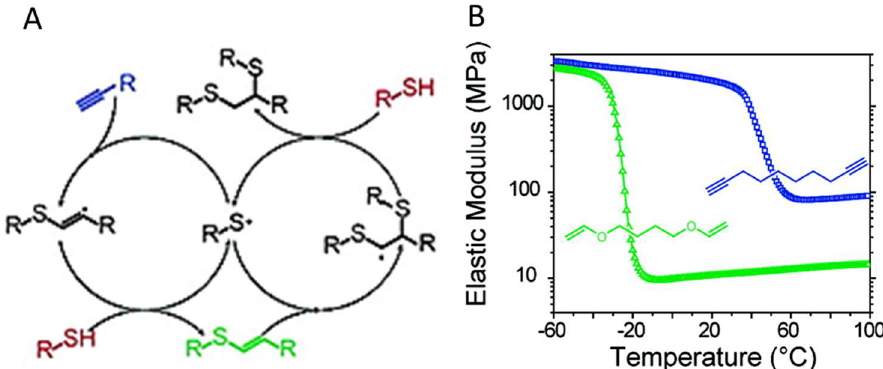
Figure 18. ( A ) A general mechanism of photoinitiated, radical-mediated thiol-yne addition. ( B ) The crosslinking between four-armed C(CH 2 OOCCH 2 CH 2 SH) 4 and a dialkyne linker produced network (blue) with a higher crosslinking density and higher elastic modulus, compared to the crosslinking between the same thiol and a dialkene linker (green). Images reproduced with from [101]. Copyright 2010 ACS.